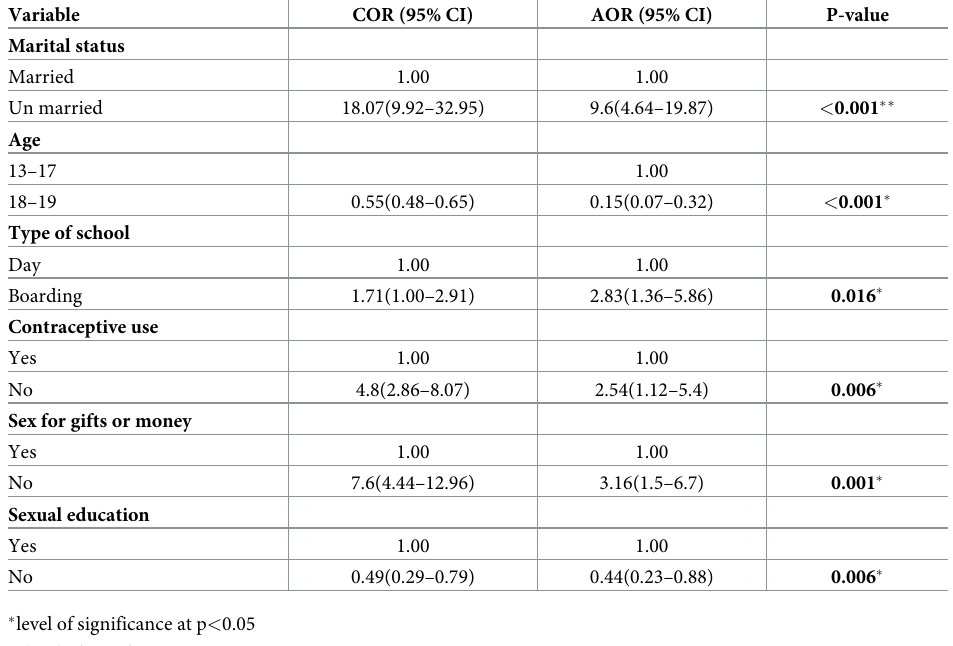
Table 2. Predictors of teenage pregnancy among in-school teenage girls aged 13–19 years in Hoima district west- ern Uganda during the COVID-19 pandemic in